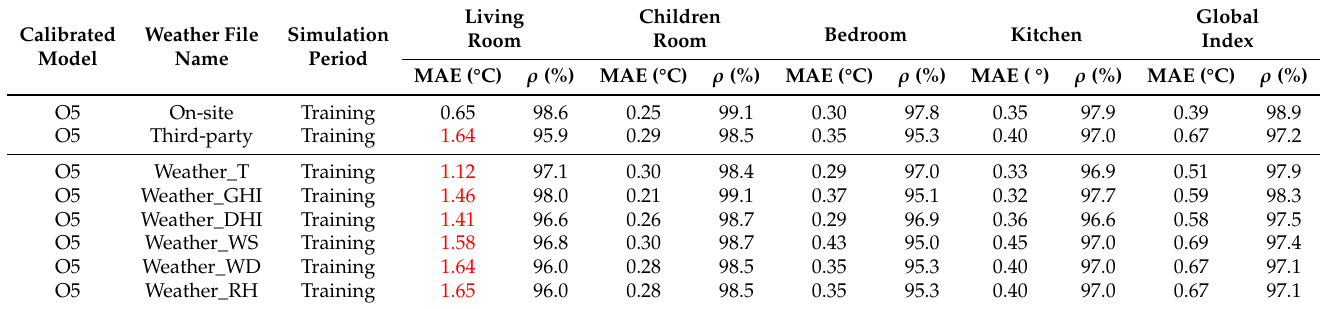
Table A7. MAE and ρ indices per thermal zone in the training period. House O5, calibrated model.